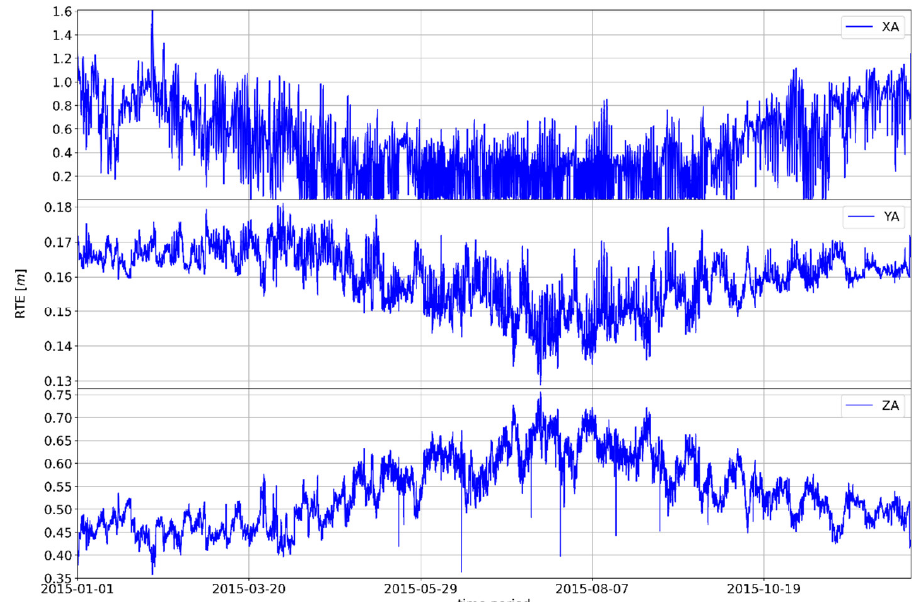
Figure A1. Movement of the absolute difference of the RTE GNSS Čakovec position parameter in 2015.